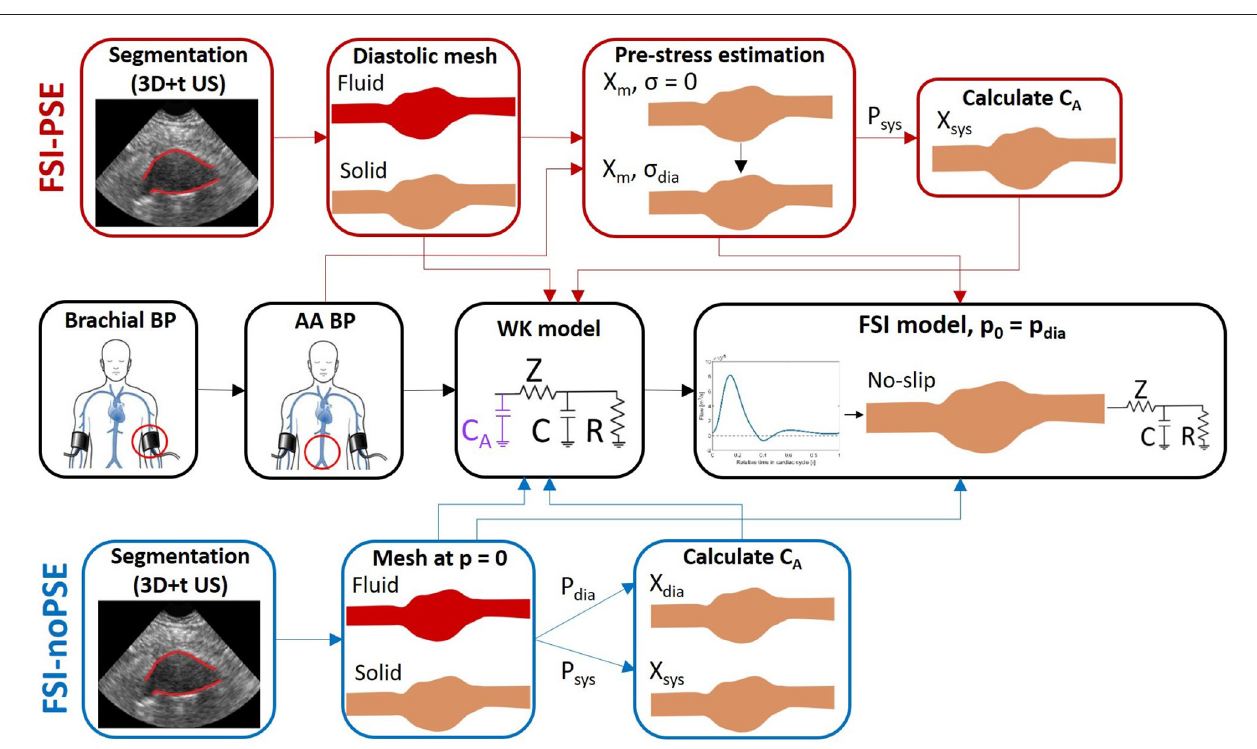
FIGURE 1 | FSI simulation pipeline with PSE (FSI-PSE, red) and without PSE (PSI-noPSE, blue). Here, 3D+t US-based segmentations and brachial blood pressure (BP) are used as patient-specific input. Note that the black boxes are used in both FSI-PSE and FSI-noPSE pipelines.